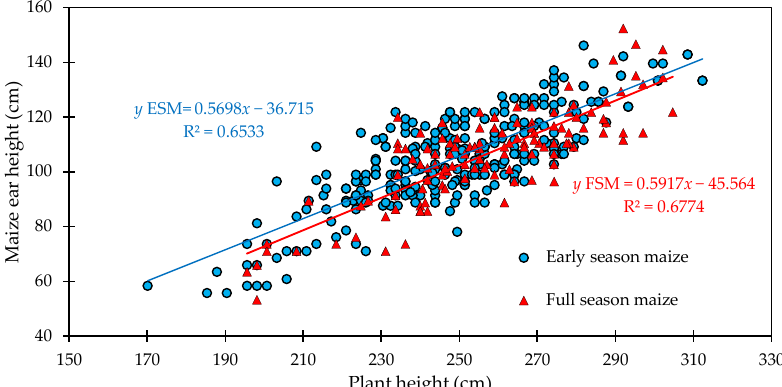
Figure 7. Relationship between maize plant height and maize ear height for the full season (FSM) and early season maize (ESM) for the 2003 – 2019 period. Agriculture 2020 , 10 , x FOR PEER REVIEW